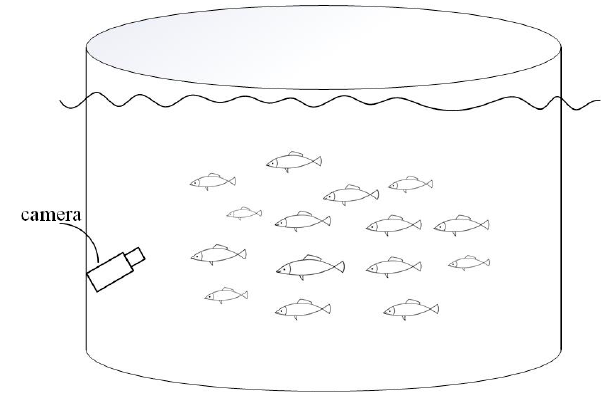
Figure 1. Data acquisition diagram.